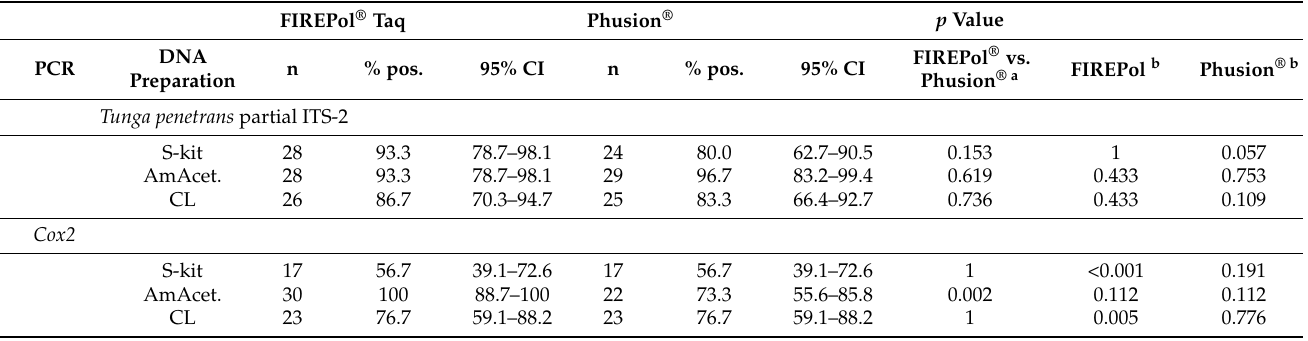
Figure 3. Representative amplification plots for the Tunga penetrans using FIREPol ® Taq ( A ) and Phusion ® ( B ) polymerases. The different DNA preparation methods are color-coded, including pink for AmAcet, blue for S-kit, and black for CL. Table 2. Success rate for different PCRs and DNA preparation methods based on 30 replicates.